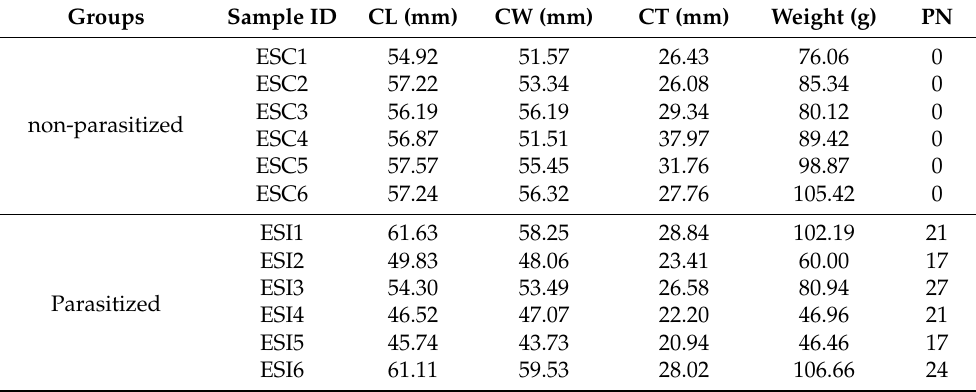
Table 1. The basic information of Chinese mitten crab